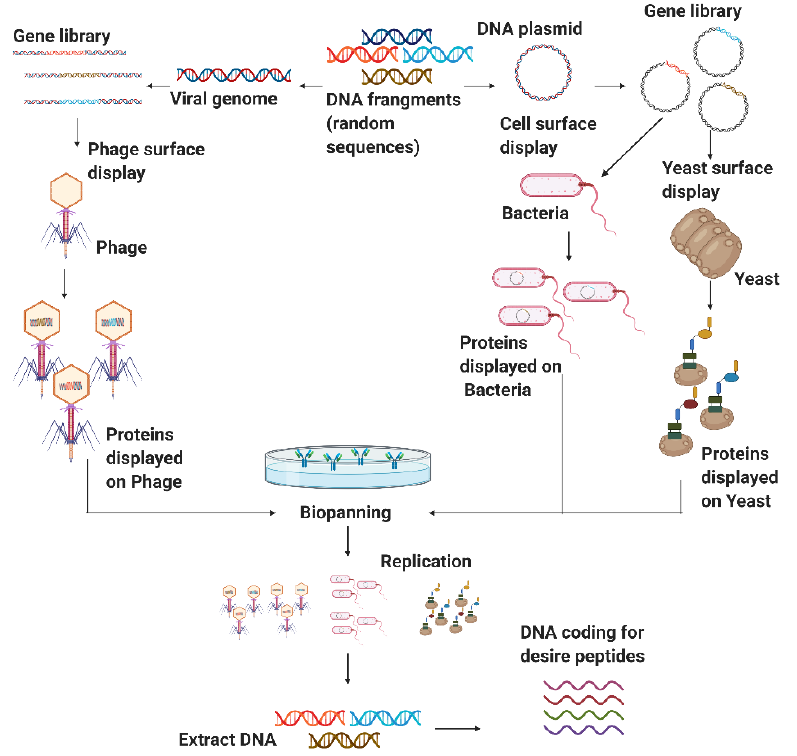
Figure 4. Scheme of the di ff erent microbial cell surface display methods. The phage display method is shown on the left, while the bacterial display process is presented in the center, and the yeast display is presented on the right. In all cases, through molecular biology tools it is possible to express the protein fragments of interest quite robustly for further biomolecular interaction analysis and screening (Created with BioRender).